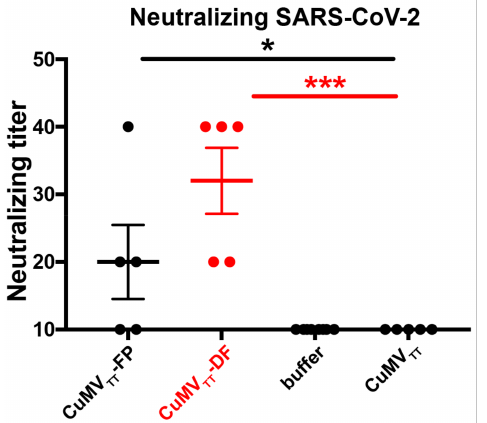
Figure 5. Titers of mice sera at d49 after CuMV TT -FP ( n = 5), CuMV TT -DF ( n = 5), buffer ( n = 7) or CuMV TT ( n = 5) [38] immunization to neutralize SARS-CoV-2 virus. The titer was expressed as highest serum dilution times to inhibit 100% cytopathogenic effect (CPE) of cells infected with SARS-CoV-2 virus. Unpaired t -test analysis was performed in GraphPad Prism 7. α = 0.05 and statistical significance were displayed as p ≤ 0.05 (*), p ≤ 0.005